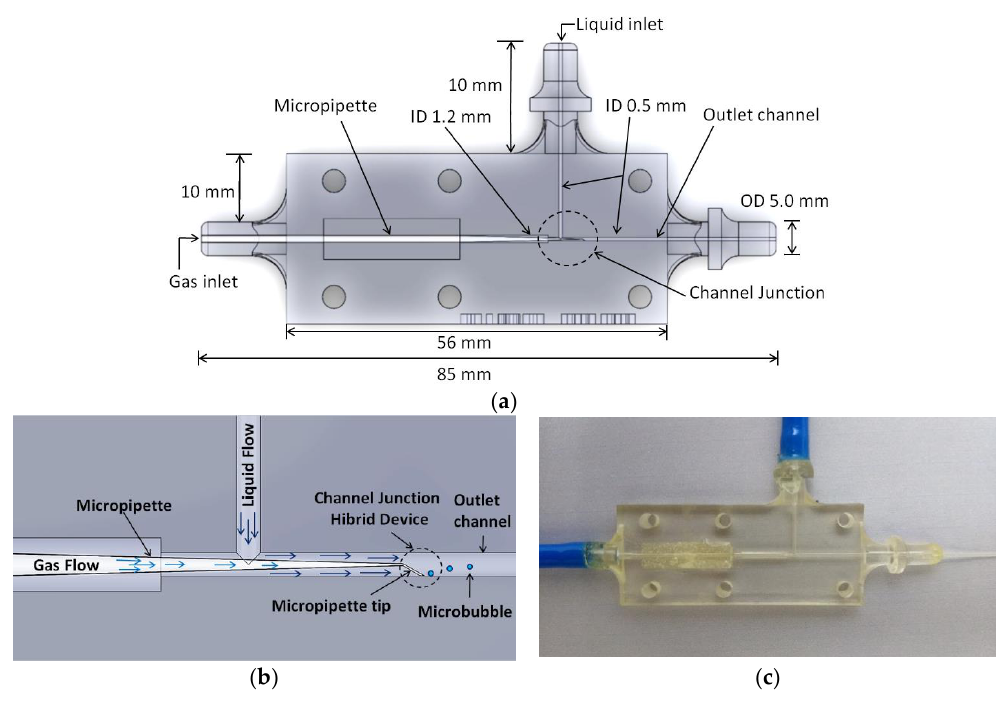
Figure 1. Hybrid microfluidic device developed in a 3D printer. In which: ( a ) represents the device developed with the technical dimensional specifications, ( b ) represents the trunk of the channel with the tip of the micropipette inserted into the device, and ( c ) the actual device with the incorporated micropipette.